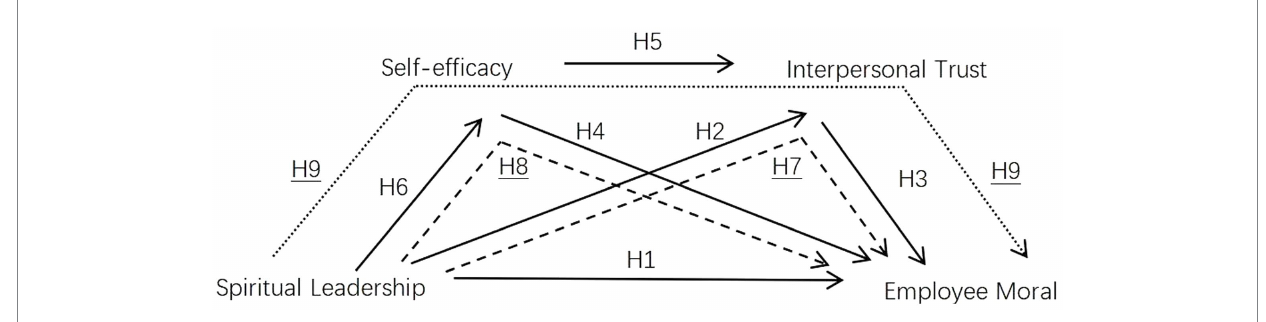
FIGURE 1 The research hypothesis model diagram: the relationship between spiritual leadership and employee morale: a chain mediation of self-efficacy and interpersonal